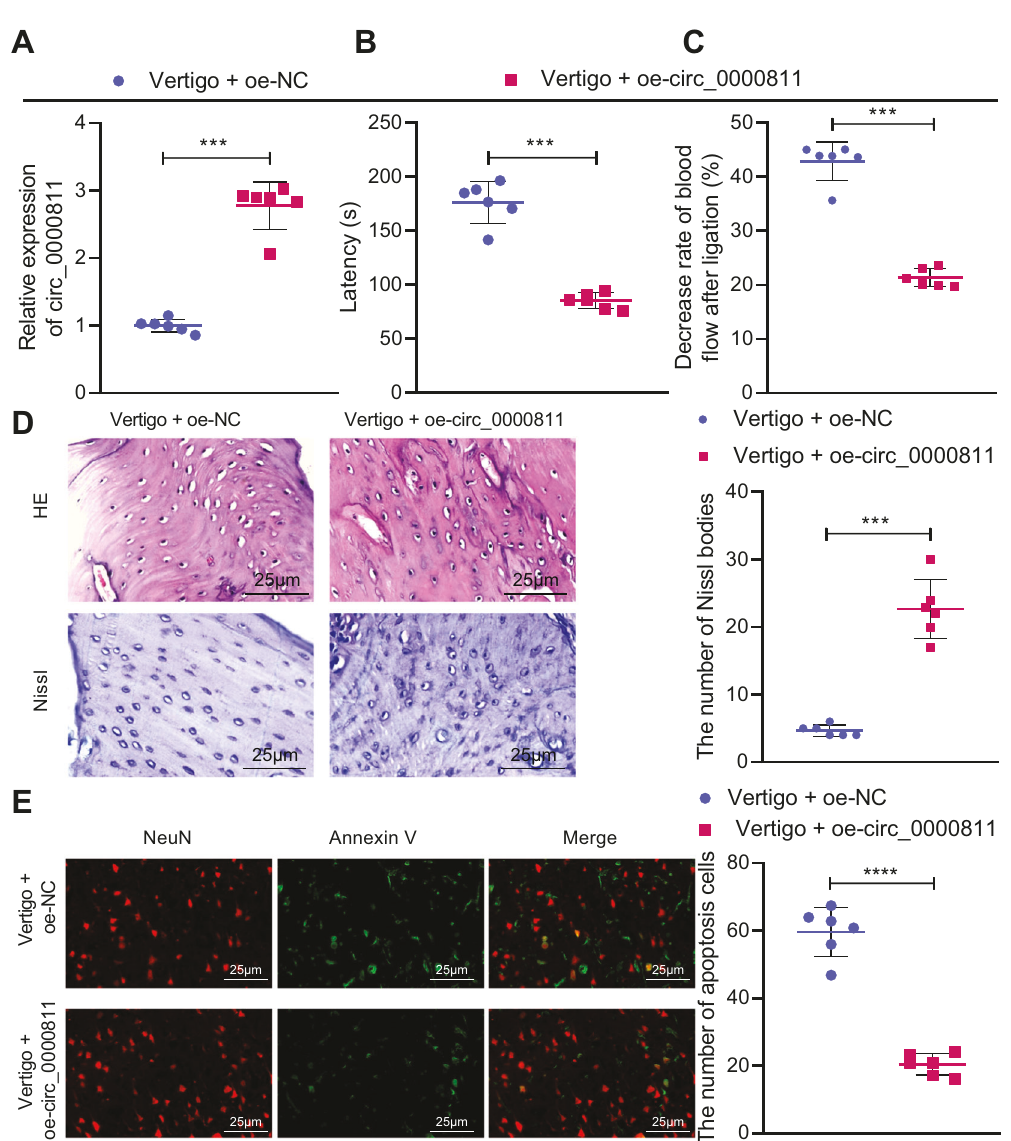
Fig. 2 Circ_0000811 overexpression alleviated experimental CI-induced vertigo in mice. A qRT-PCR to determine the expression of circ_0000811 in the MVN of mice with CI-induced vertigo in response to circ_0000811 overexpression; B the escape latency of mice with CI- induced vertigo in response to circ_0000811 overexpression; C the decrease rate of blood fl ow in the MVN of mice with CI-induced vertigo in response to circ_0000811 overexpression; D H&E and Nissl staining to detect the histopathological changes of the MVN of mice with CI- induced vertigo in response to circ_0000811 overexpression; E NeuN/Annexin counterstaining to detect the apoptotic rate of neurons in the MVN of mice with CI-induced vertigo in response to circ_0000811 overexpression. *** p < 0.001 compared with the Vertigo + oe-NC group. The independent sample t test was applied for the comparison between two groups. CI cerebral ischemia, qRT-PCR quantitative reverse- transcription polymerase chain reaction, MVN medial vestibular nucleus, H&E hematoxylin and eosin; NeuN neuronal